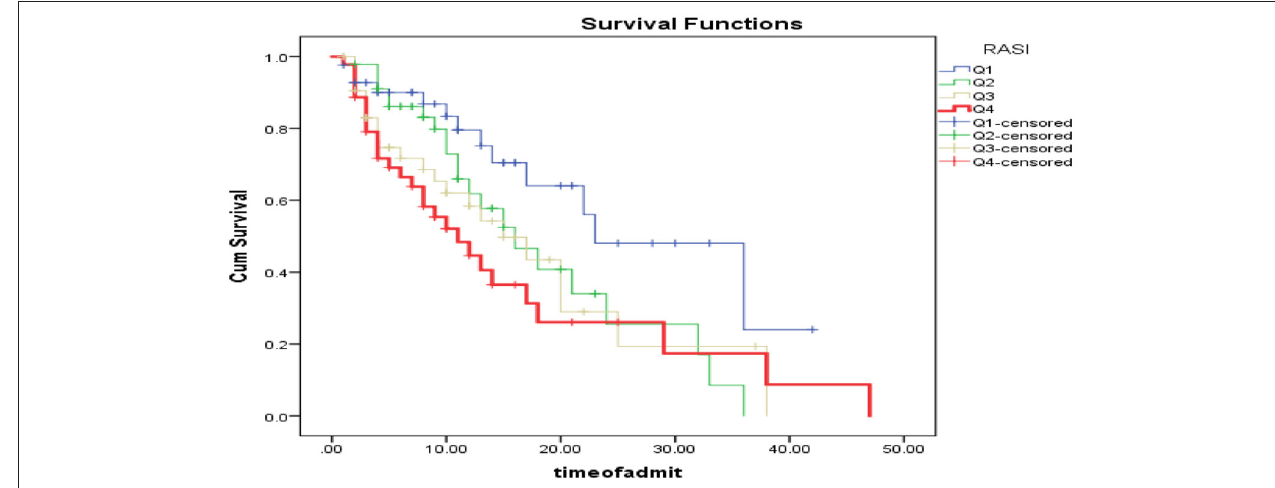
FIGURE 3 | Patient survival analysis based on RASI quarters.